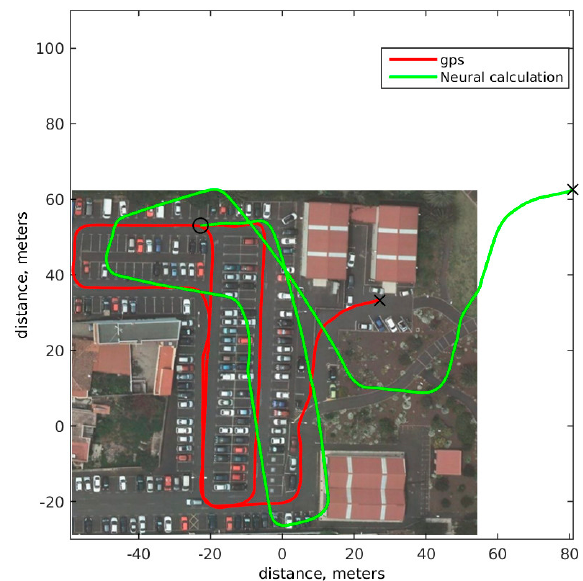
Figure 9. Odometric model based on neural network. Solid red ground truth GPS route. Solid green neural network odometric model path.